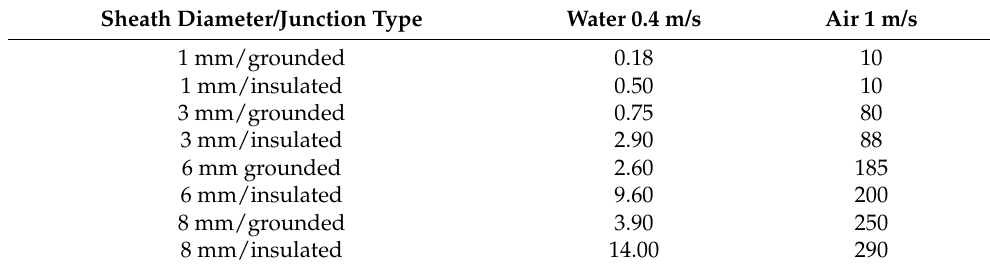
Table 4. The time after which the thermocouple’s response to a step change in temperature reaches 90% of its maximum value, s.